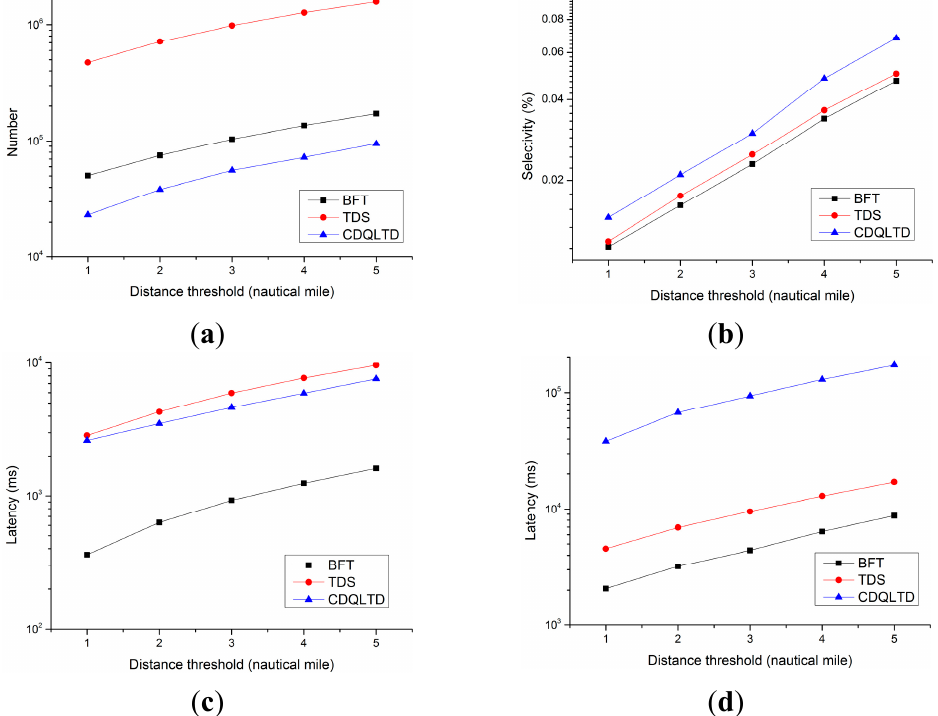
Figure 10. Performance of different distance thresholds: ( a ) Number of the accessed nodes, ( b ) selectivity, ( c ) pruning latency, ( d ) query latency.